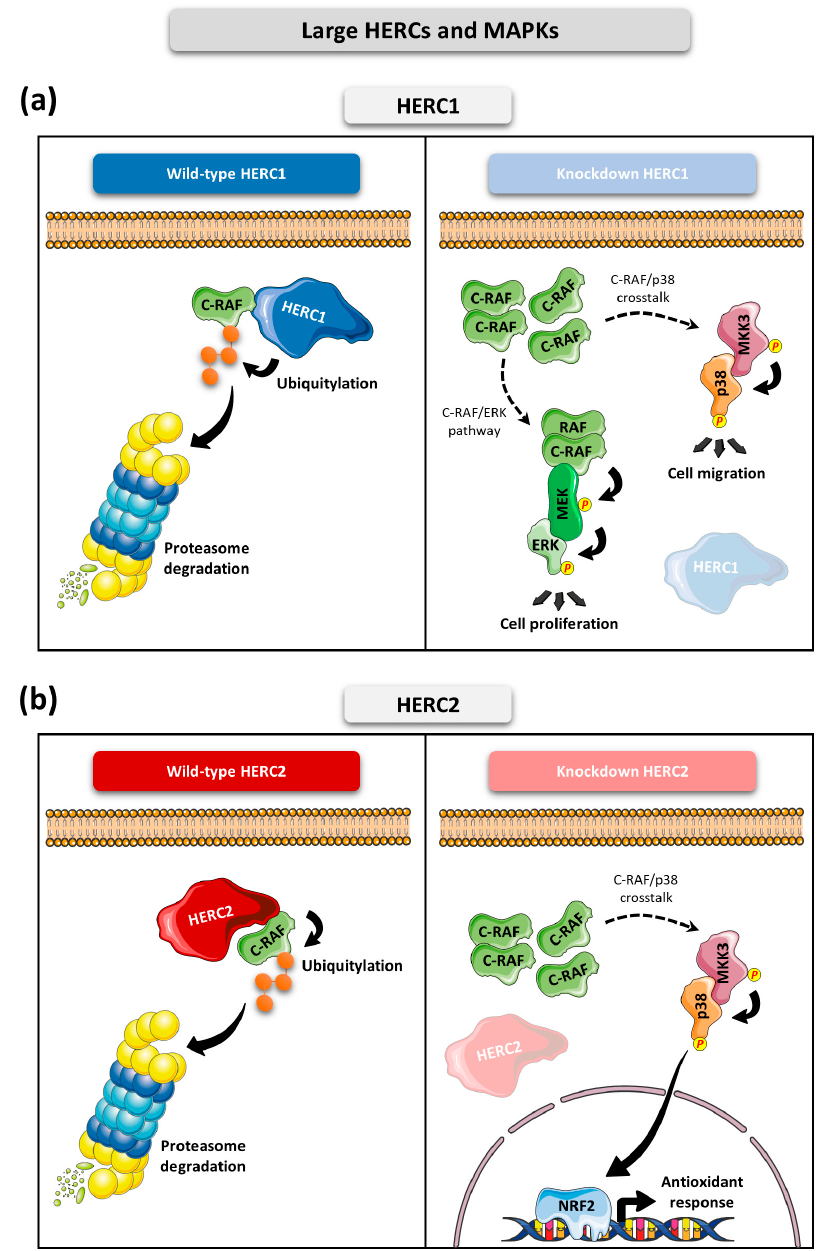
Figure 3. Large HERCs and MAPKs. ( a ) The N-terminal part of HERC1 interacts with the kinase domain of C-RAF, located in the C-terminus [66]. Through this interaction HERC1 regulates the protein levels of C-RAF via a ubiquitin-mediated proteasomal degradation mechanism. Knockdown of HERC1 causes accumulation of C-RAF protein. On one hand, this accumulation triggers over- activation of ERK signaling, thus enhancing cell proliferation. On the other hand, increased levels of C-RAF activate crosstalk between ERK and p38 pathways at the level of MKK3. Hence, p38 is phosphorylated and activated, which eventually promotes cell migration. ( b ) The C-terminal part of HERC2 interacts with C-RAF in its C-terminus kinase domain [68]. By this means, HERC2 controls protein levels of C-RAF by regulating its ubiquitylation and subsequent proteasomal degradation. Knockdown of HERC2 causes an increase in C-RAF protein levels. This C-RAF protein accumulation activates crosstalk between the C-RAF and MKK3/p38 signaling pathways which eventually induces the stabilization of NRF2 and leads to overactivation of the cellular antioxidant